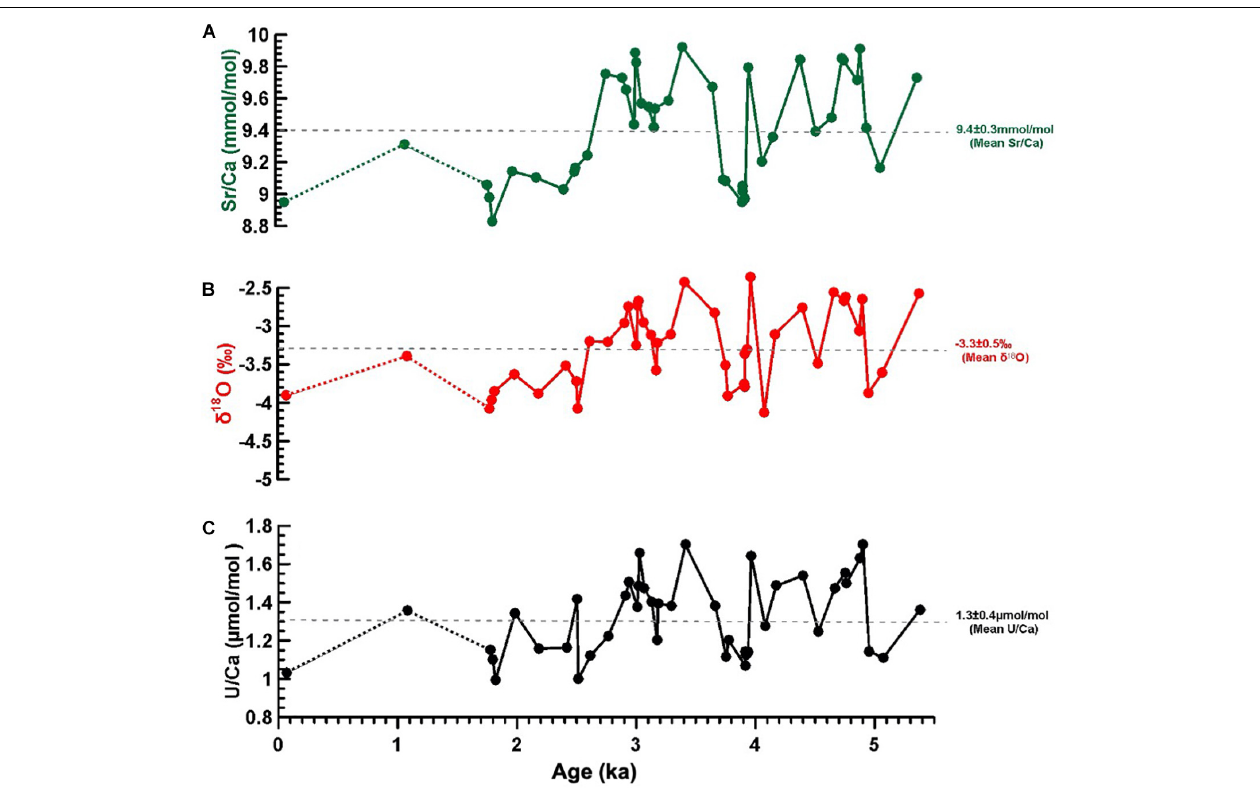
FIGURE 3 | (A) Sr/Ca; (B) δ 18 O; and (C) U/Ca series from the measured corals plotted against the corresponding ages. Dotted line in each of the series between ∼ 1–2 ka indicates time interval with only few data points, where the trend should not be considered confident. The gray dashed line represents the average value for each